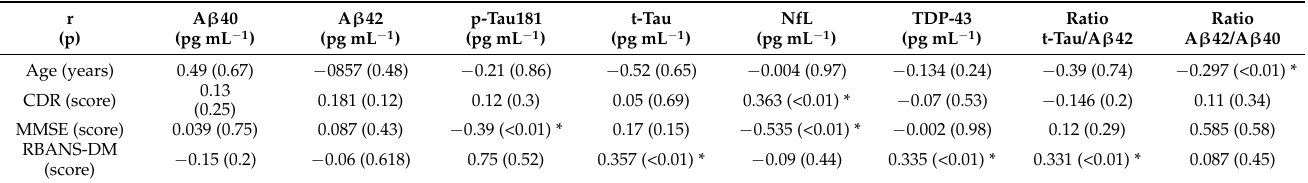
Table 7. Correlations between plasma biomarkers vs. neurocognitive performance and